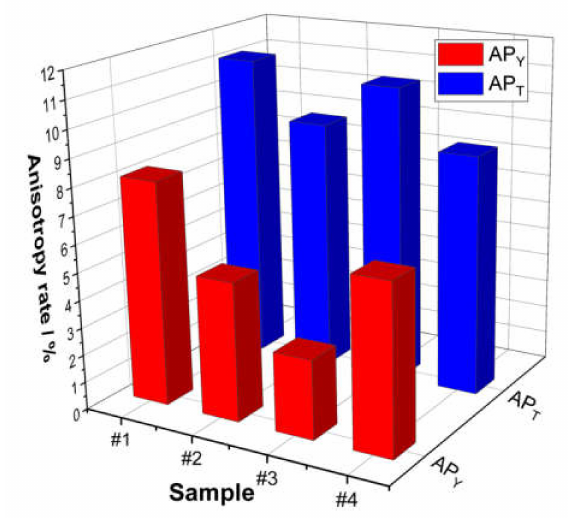
Figure 13. Anisotropy of yield and tensile of di ff erent specimens in horizontal and vertical